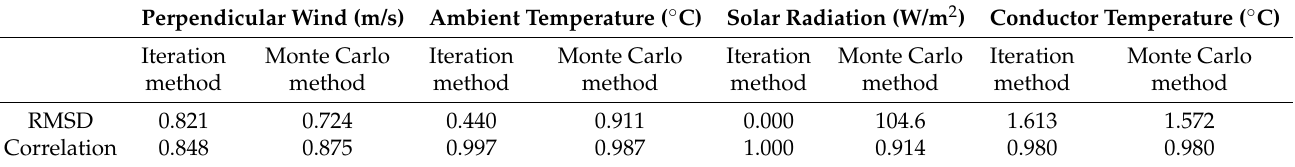
Table 1. Numerical results of RMSD (for metheorological variables) and RMSE (for conductor temperature) differences between measured and estimated values.